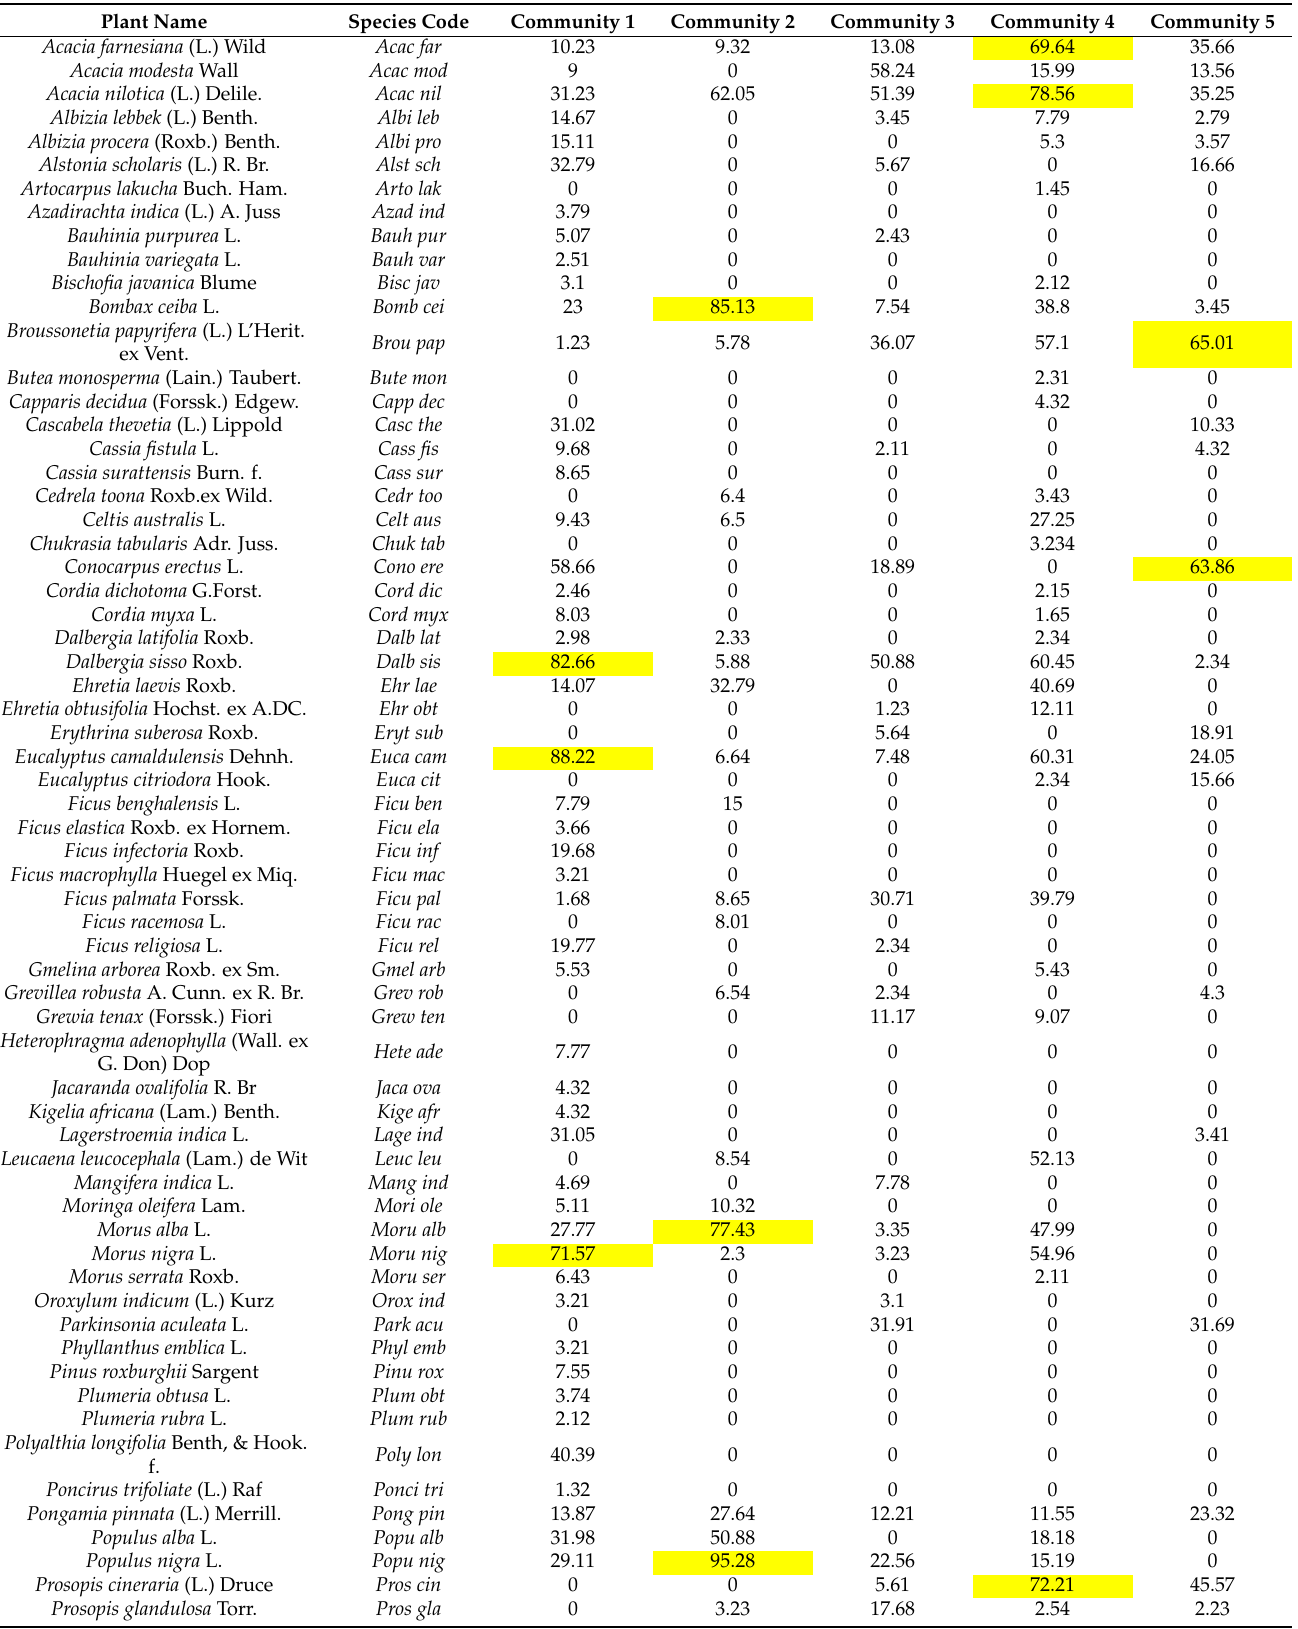
Table 1. overall woody plants of the five communities from the study area of semi-arid lowland district Kasur Punjab,